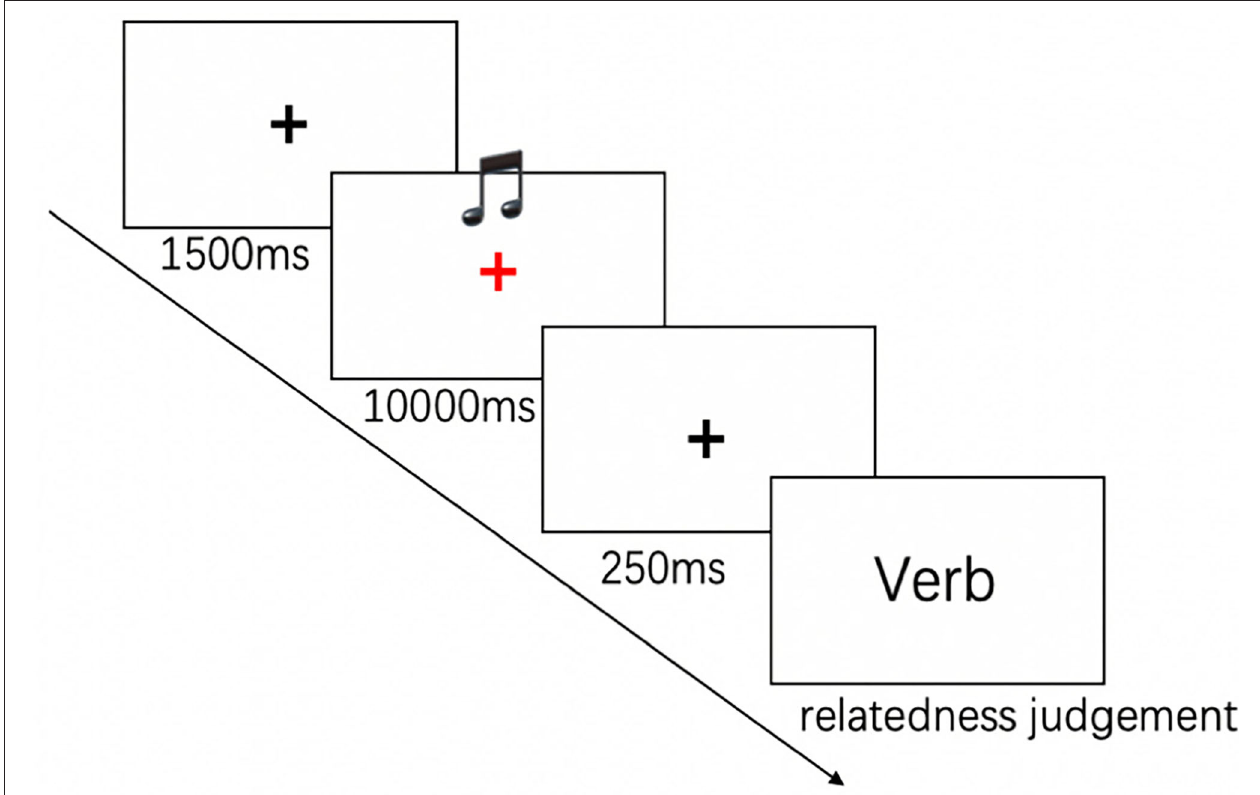
FIGURE 2 | The procedure of Experiment